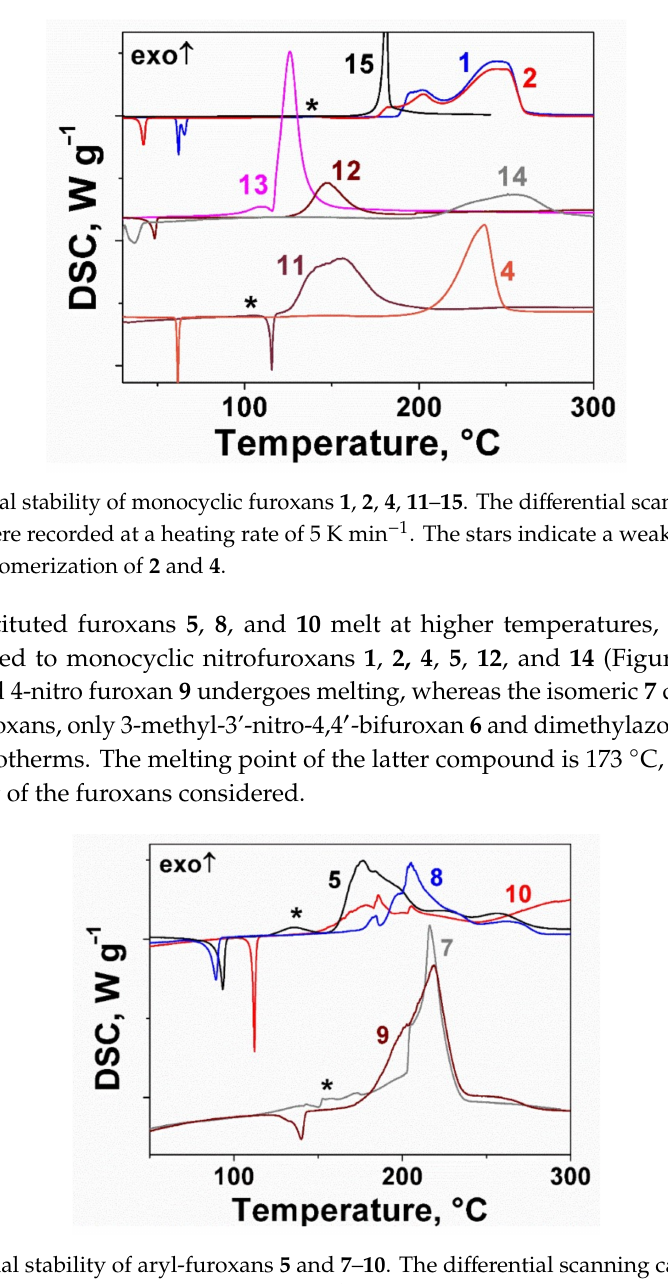
Figure 6. Thermal stability of aryl-furoxans 5 and 7 – 10 . The di ff erential scanning calorimetry (DSC) curves were recorded at a heating rate of 5 K min − 1 . The star indicates a weak heat release due to the thermal isomerization of 5 and 7